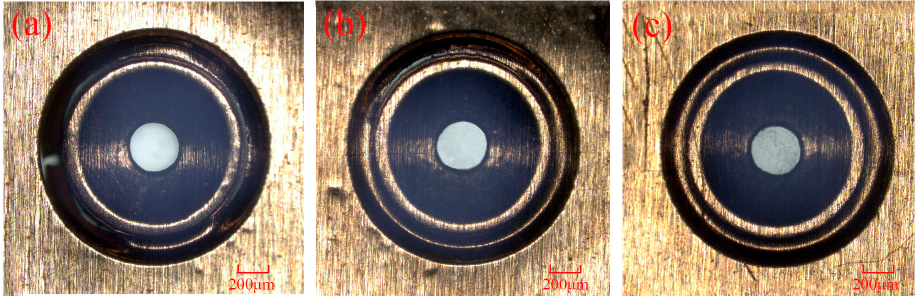
Figure 8. The morphology of the work piece under the laser energy of 1550 mJ when the thickness of the soft punch is ( a ) 200 µ m ( b ) 300 µ m ( c ) 400 µ m.